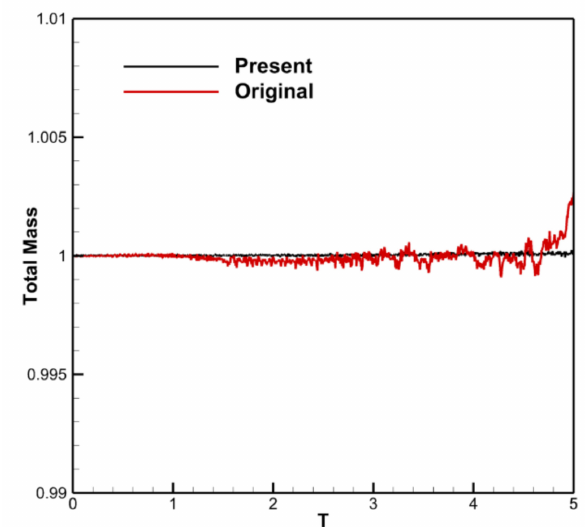
Figure 14. Interface positions and velocities of the bubble and spike for the Rayleigh–Taylor instability at Re = 256 compared with references [10,22]: ( a ) interface positions, ( b ) interface velocities.